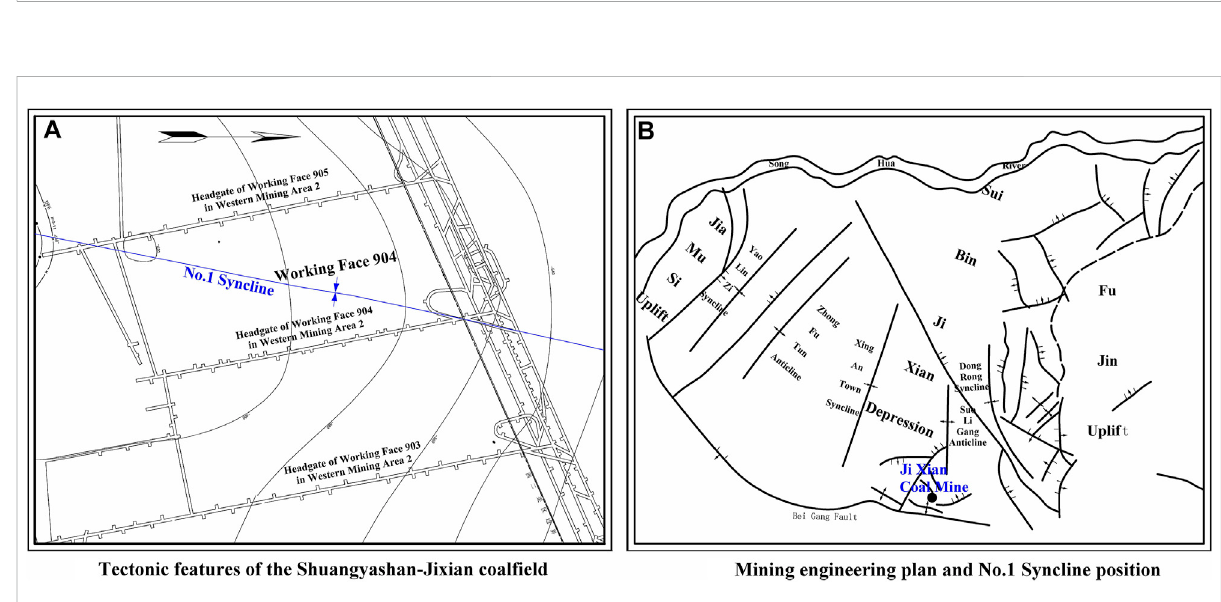
FIGURE 1 Structural evolution of eastern Heilongjiang Basin.